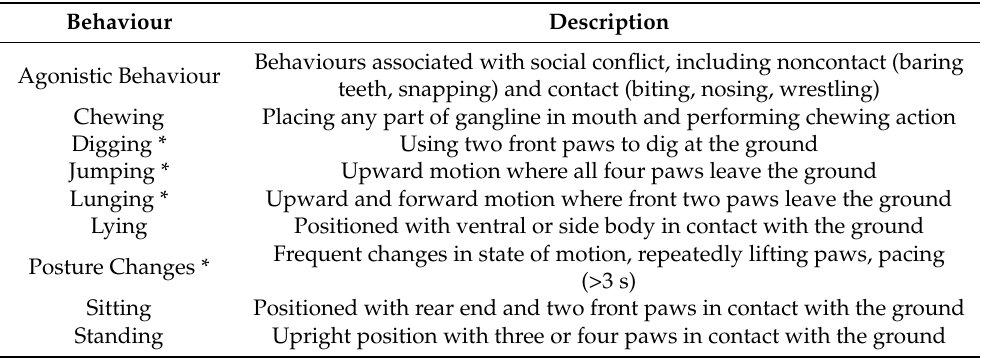
Table 2. Description of behavioural parameters analysed during 5 min of video taken immediately pre- and post-exercise for actively training sled dogs 1 . Behaviour Agonistic Behaviour teeth, snapping) and contact (biting, nosing, wrestling) Chewing Placing any part of gangline in mouth and performing chewing action Digging * Using two front paws to dig at the ground Jumping * Upward motion where all four paws leave the ground Lunging * Upward and forward motion where front two paws leave the ground Lying Positioned with ventral or side body in contact with the ground Frequent changes in state of motion, repeatedly lifting paws, pacing Posture Changes * (>3 s) Sitting Positioned with rear end and two front paws in contact with the ground Standing Upright position with three or four paws in contact with the